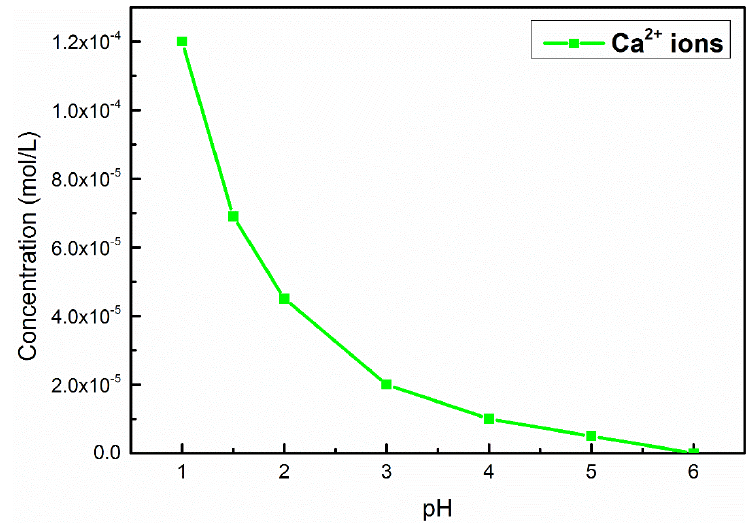
Figure 5. The concentration of Ca 2+ ions as a function of pH. Table 2. The radius of metal ions (All are 6 coordinated).